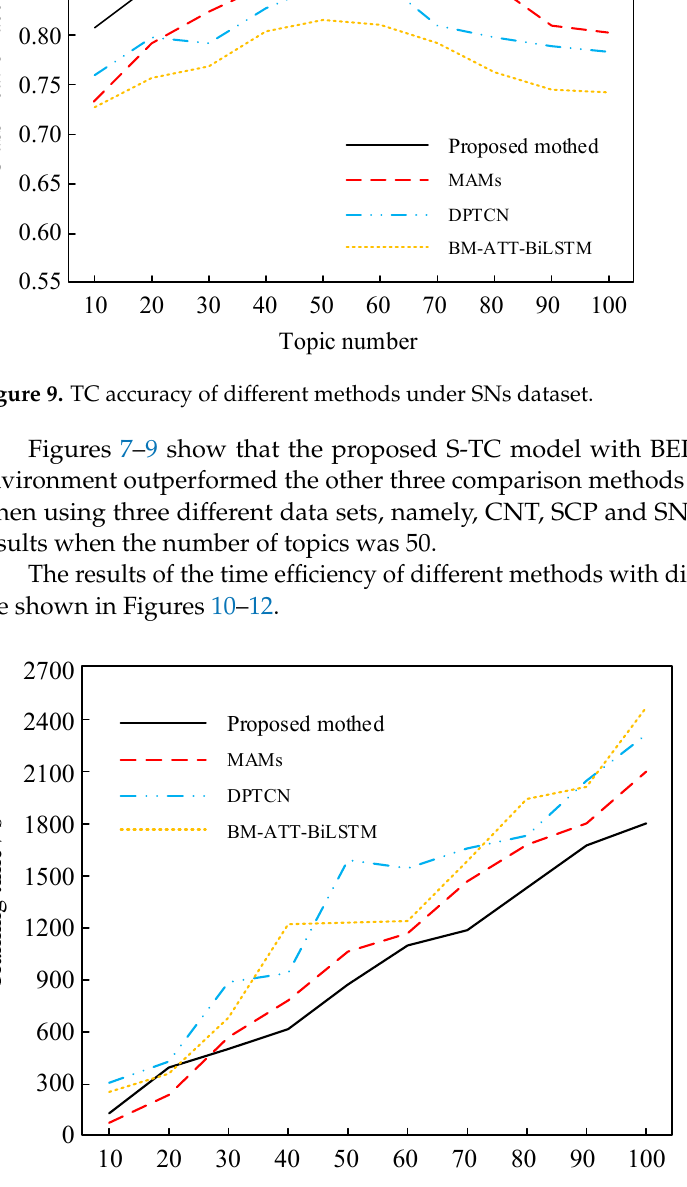
Figure 8. TC accuracy of different methods under SCP dataset.